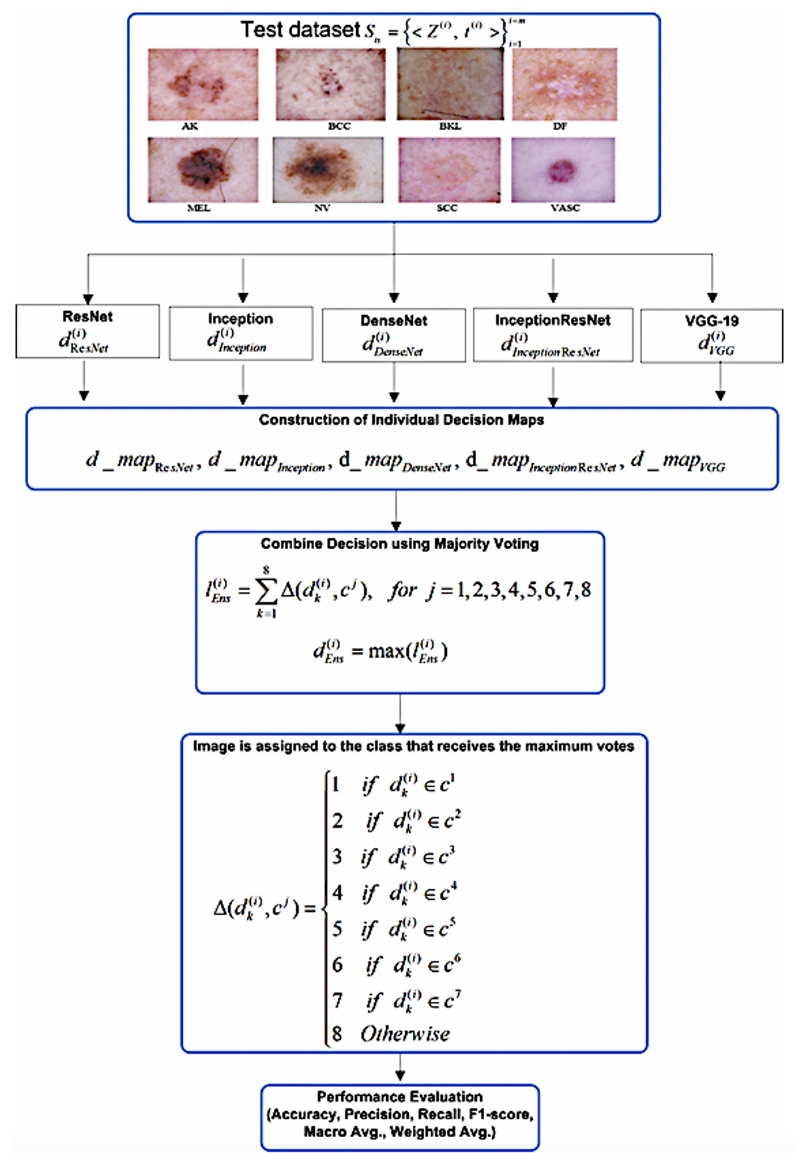
Figure 2. Block diagram of ensemble model.